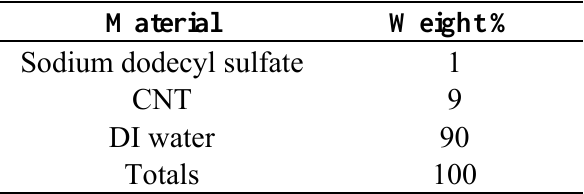
Table 1. Composition of the CNT